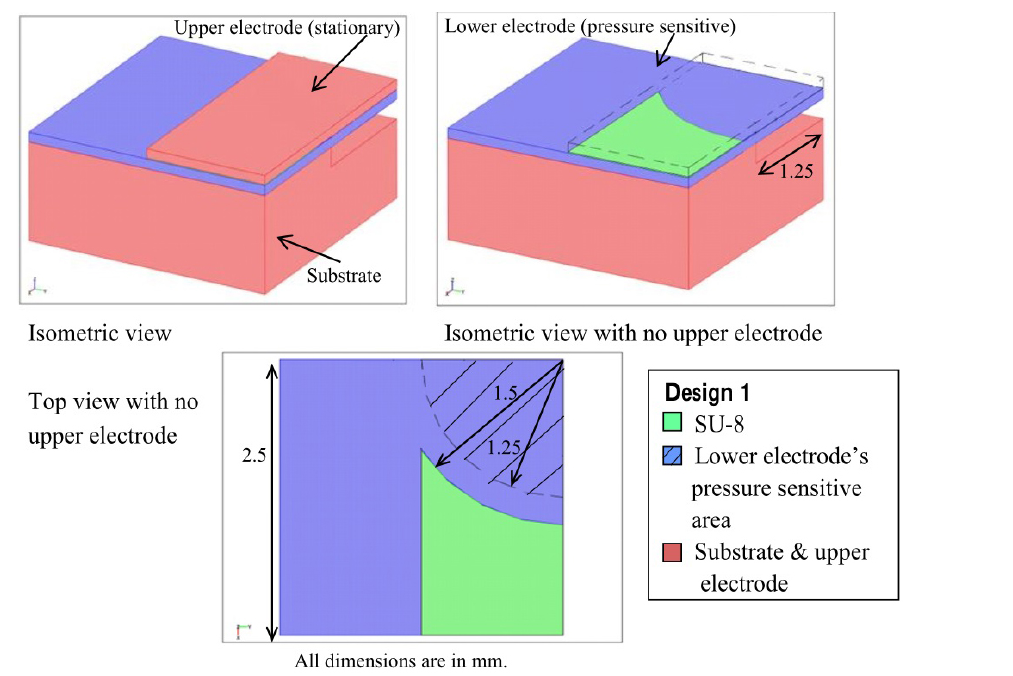
Figure 13. A three-dimensional view of a quarter of the circular diaphragm pressure